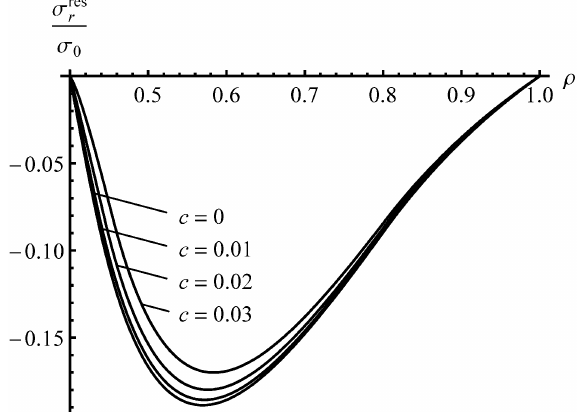
= 0.4 cylinder. Materials 2020 , 13 , x FOR PEER REVIEW